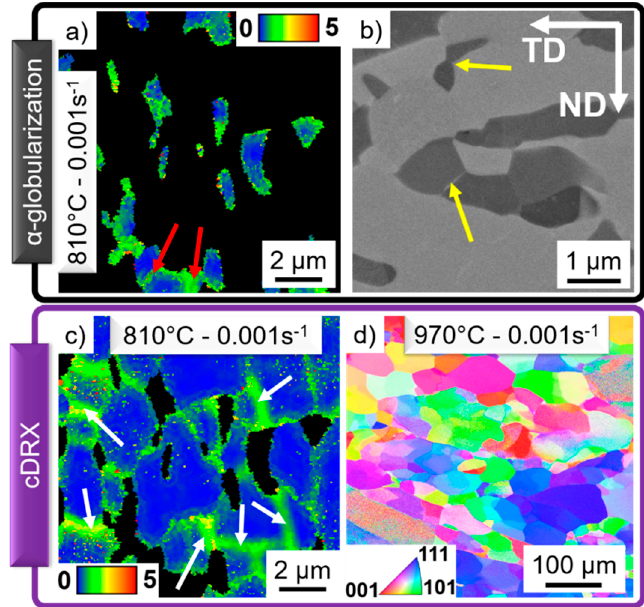
Figure 4. Typical microstructures of the Ti-17 deformed at 0.001 s − 1 and ( a – c ) 810 °C, ( d ) 970 °C; representing the process of ( a , b ) dynamic α -globularization; ( c , d ) cDRX.